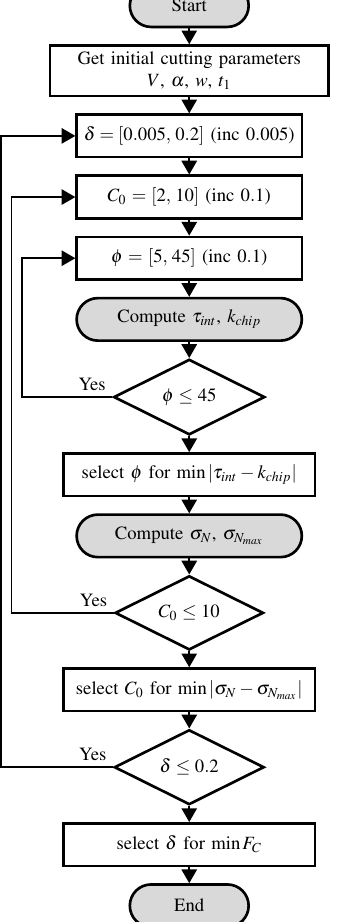
Figure 3. The simplified flowchart implementation for the computation of φ , C 0 , δ conforming to the one proposed by Oxley